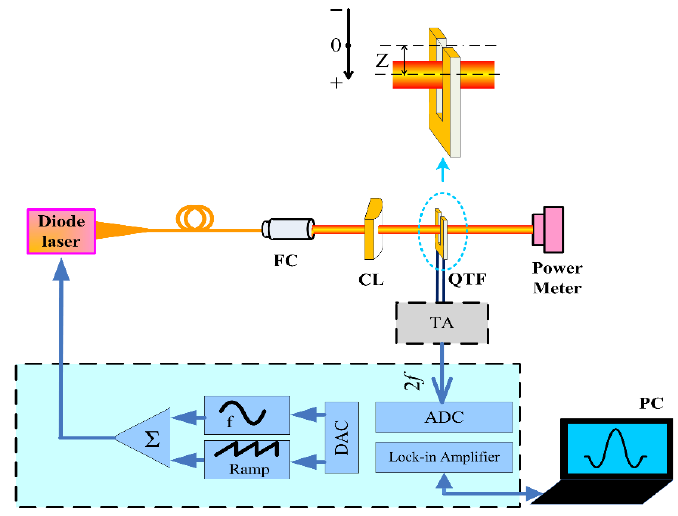
Figure 1. Schematic configuration of the reported QEPAS-based sensor platform.